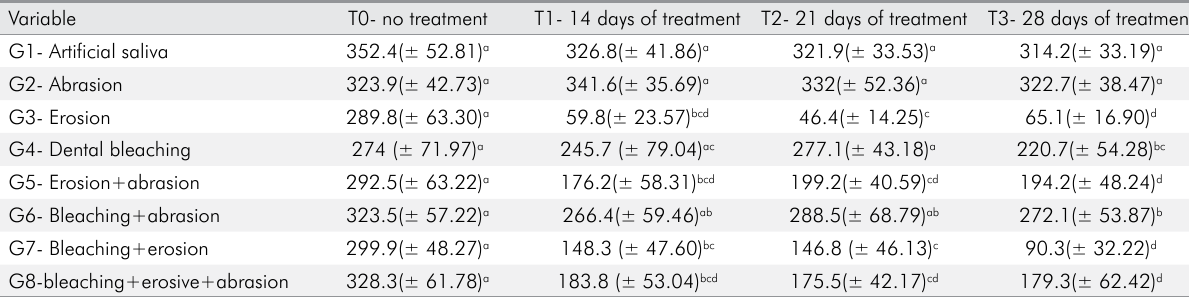
Table 3. Mean ± SD values for MH tests, analysed by two-way ANOVA for repeated measures as a function of time.